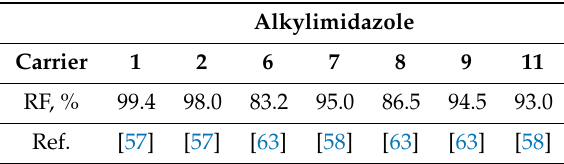
Table 8. The values of Cu(II) recovery factors (RF) after a 24-h transport across PIMs doped with